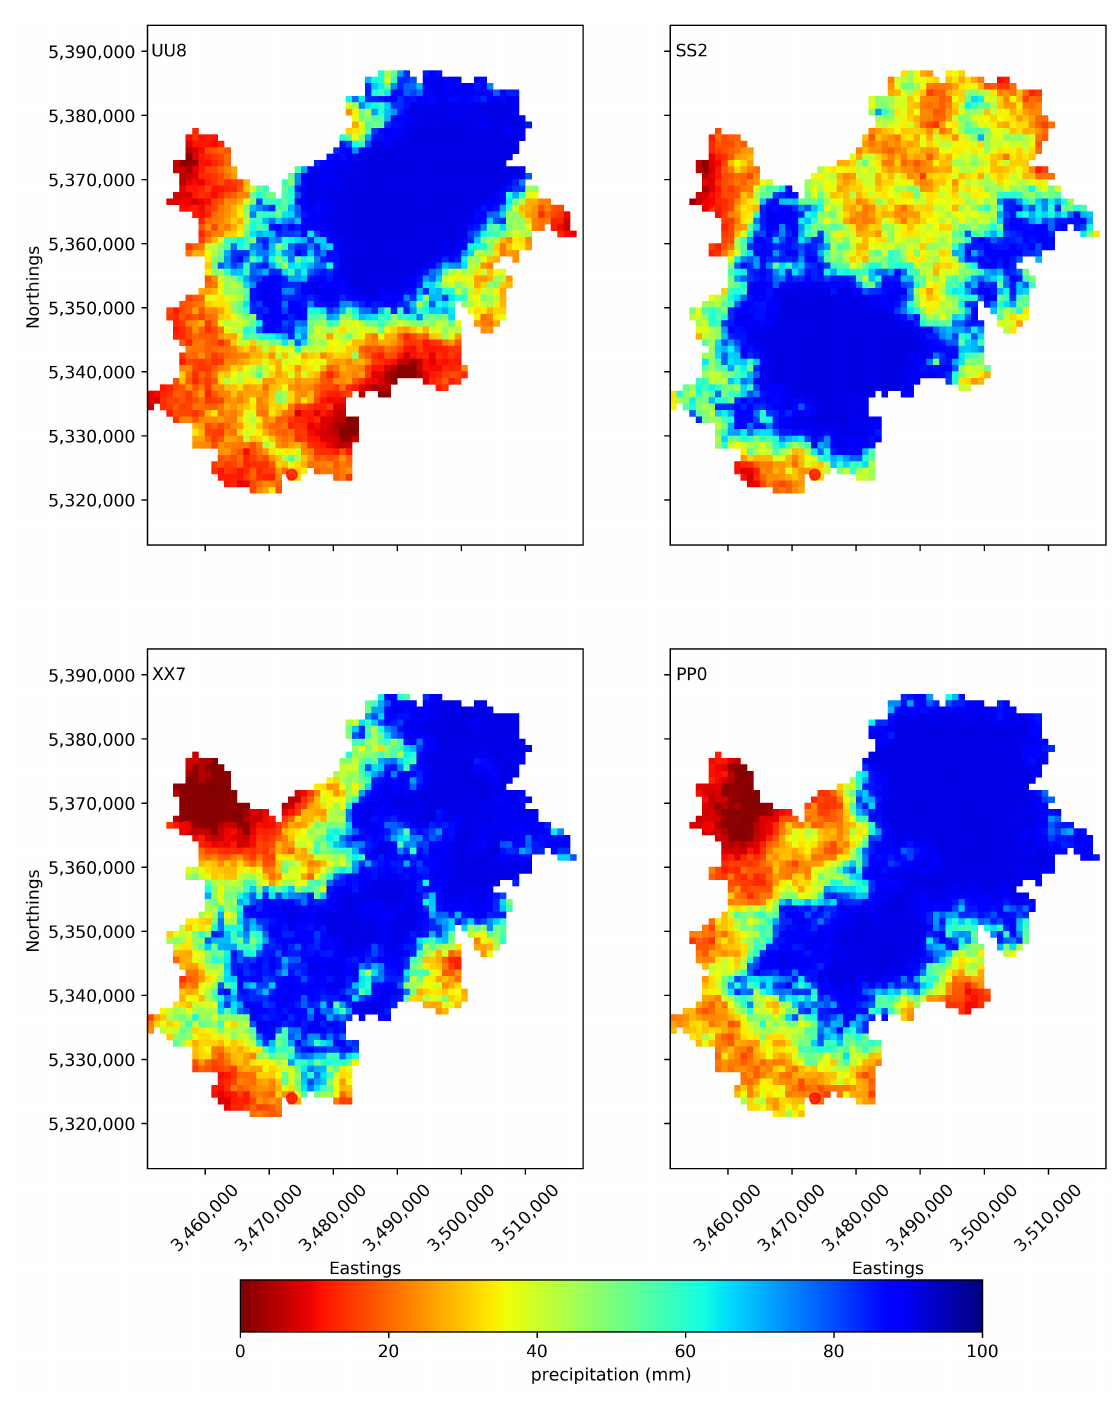
Figure 11. Gridded simulated precipitation fields for 25 December 1882. The upper two panels show the most dissimilar simulated pair, the lower the most similar